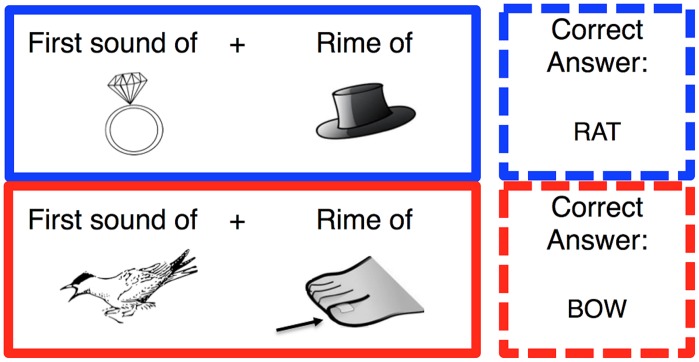
Example stimuli in the Phonemic Manipulation Task. Participants were told to take the first sound from the left image and the rime of the right image to make a new word. The shallow trials (blue) were designed so that the task could be completed based on orthography alone (e.g., the first sound of ‘Ring’ + the rime of ‘hAT’ = RAT). The deep (red) trails were designed such that orthography alone could not be used to accurately complete the task (e.g., the first sound of ‘Bird’ + the rime of ‘tOE’ = BOW). The correct answer was not provided to participants as feedback, but is provided in the figure for clarity.